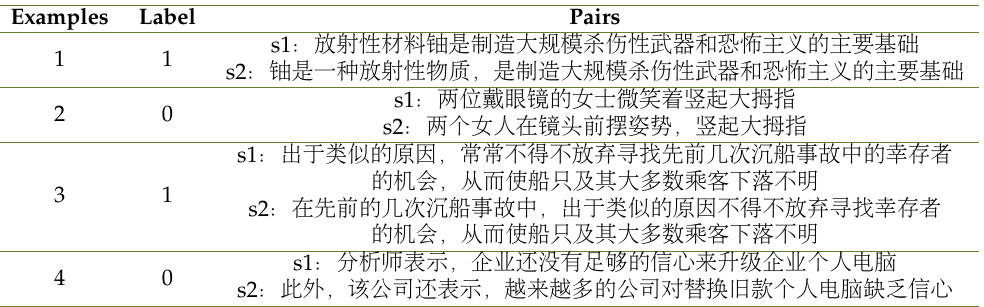
Table 1. Examples from NCSS dataset